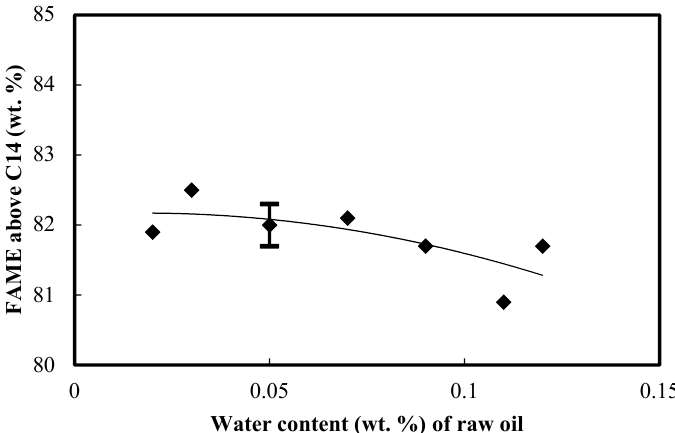
Figure 6. Variations of the fatty acid methyl esters (FAME) above C14 of the biodiesel product with the initial water content in the raw palm oil.